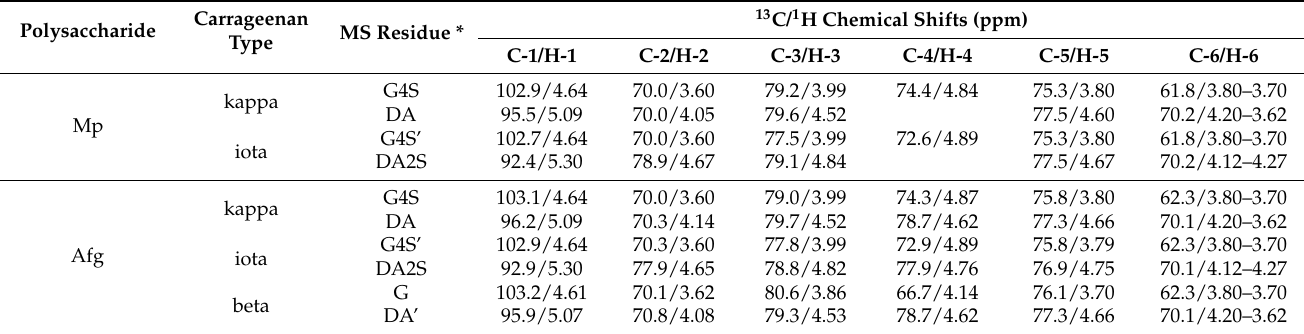
Table 2. 1 H and 13 C NMR signals (ppm) of Afg and Mp polysaccharides.